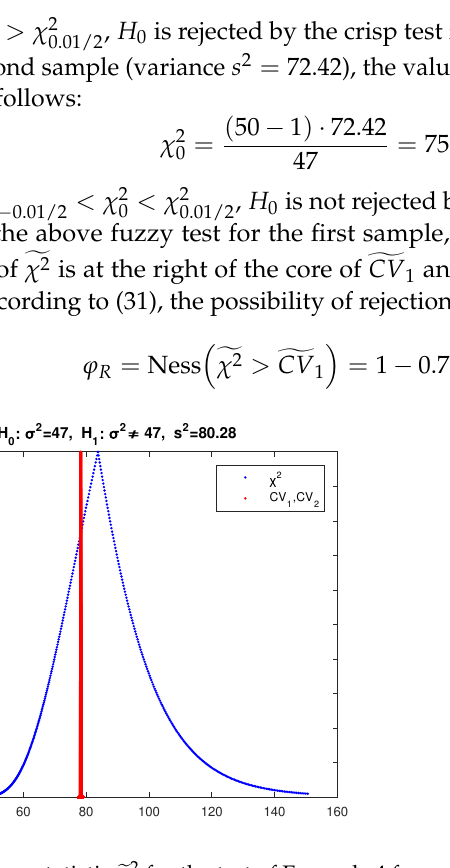
Figure 11. The fuzzy statistic (cid:101) χ 2 for the test of Example 4 for a sample with variance s 2 = 82.28.